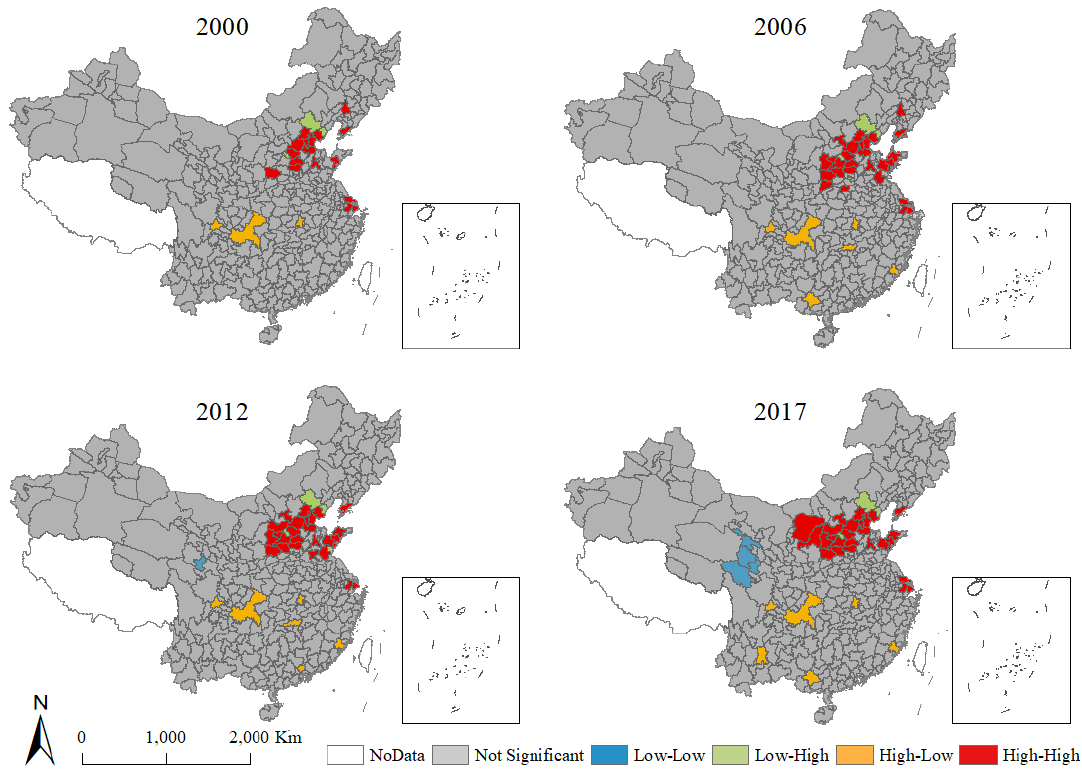
Figure 8. Spatial autocorrelation of carbon emissions at the city level for the periods 2000–2017.